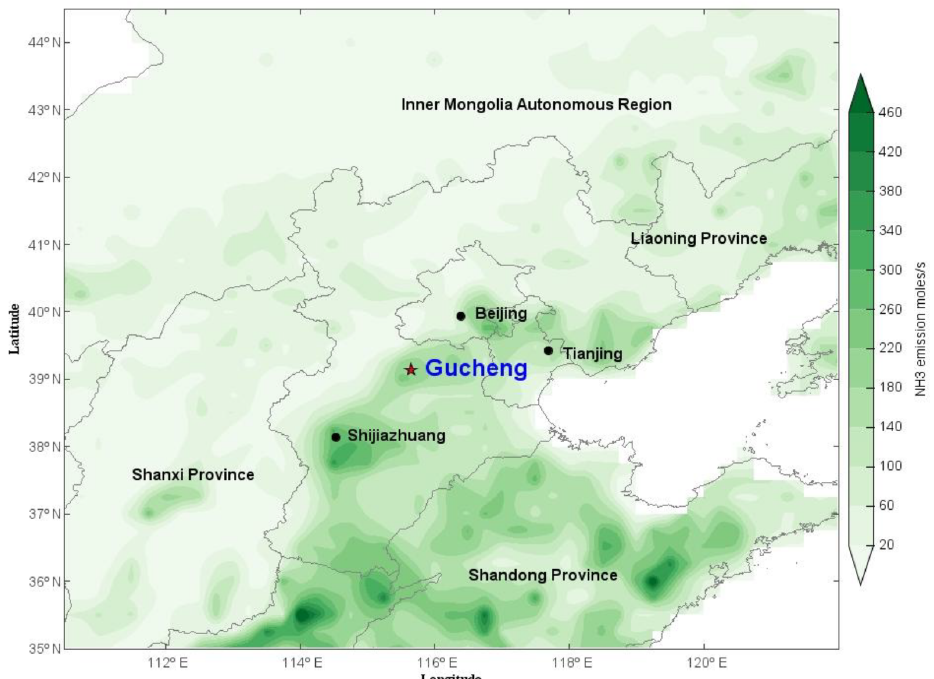
Figure 1. Sampling location in the North China Plain with emission distributions of NH 3 for the year 2012 from the multi-resolution emission inventory of China